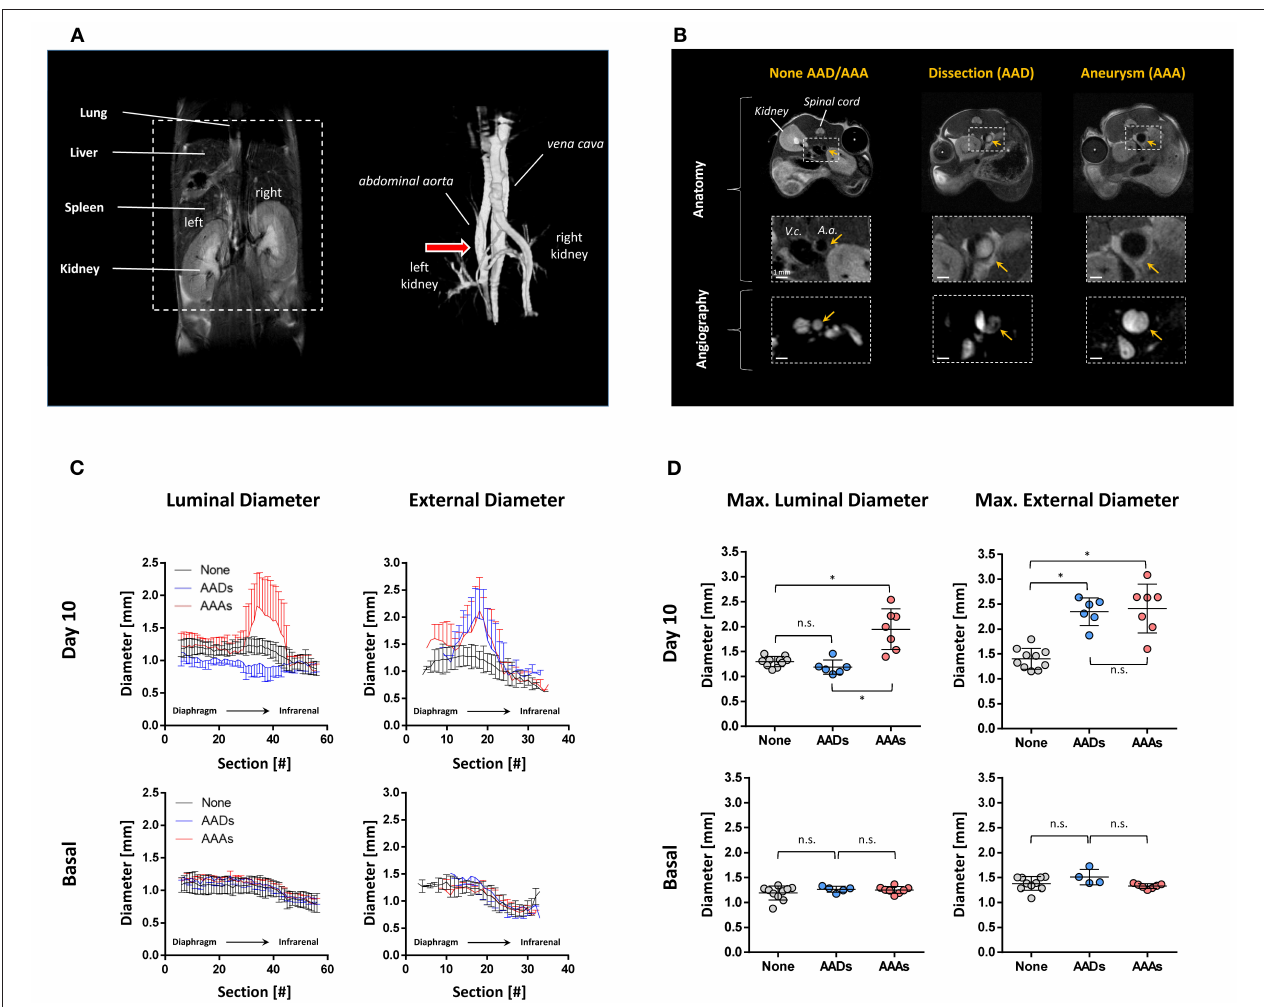
FIGURE 1 | 1 H MRI of angII-induced aortic disorders. (A) Coronal 1 H MRI of the abdominal area (left) and a 3D reconstruction of the corresponding 1 H MR angiography (right). The dashed lines represent the area inspected for the analysis of AAA and AAD. The red arrow highlights the site where AAAs/AADs predominantly develop. (B) Upper panel: Axial 1 H MRI cross sections of mice treated with angiotensin II for 10 days. Middle: Magnification of the aortic area indicated by the dashed lines. Lower: Corresponding MR angiographic slices. Yellow arrows indicate the site of the aorta. None, mouse without developing AAA/AAD phenotype. (C) Quantification of the luminal and external anteroposterior diameters of the aorta before implantation of angII minipumps (basal) and on day 10 of angII treatment. The number of sections indicate the position of the scans from cranial (diaphragm. i.e., #1) to caudal ( ∼ bottom of kidneys, i.e., #40). (D) Maximal